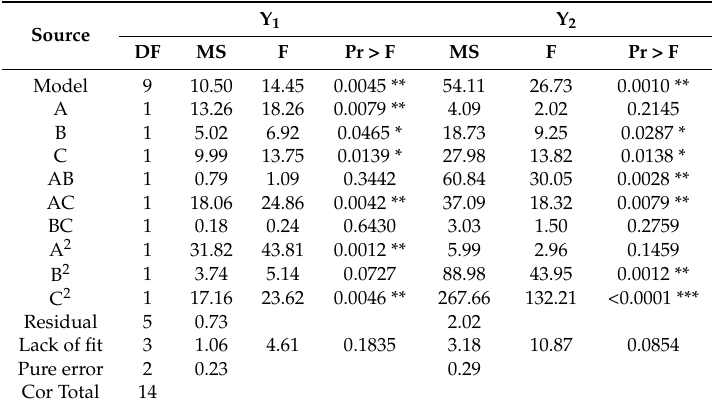
Table 6. ANOVA of the response variables for the hydroxyl free radical scavenging rate (Y 1 ) and the DPPH radical scavenging rate (Y 2